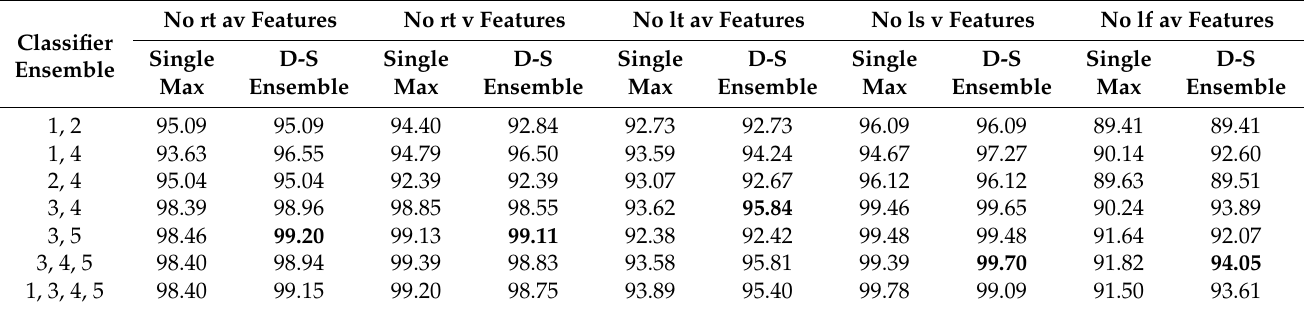
Table 7. The accuracies (%) of the related multiple classifier fusion models.